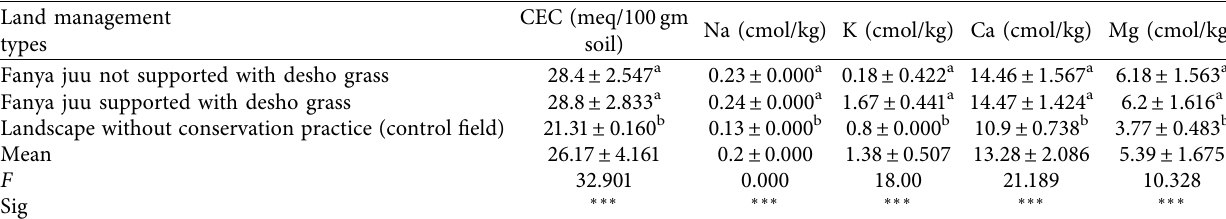
Table 3: Efects of land management on selected soil properties (mean ± standard